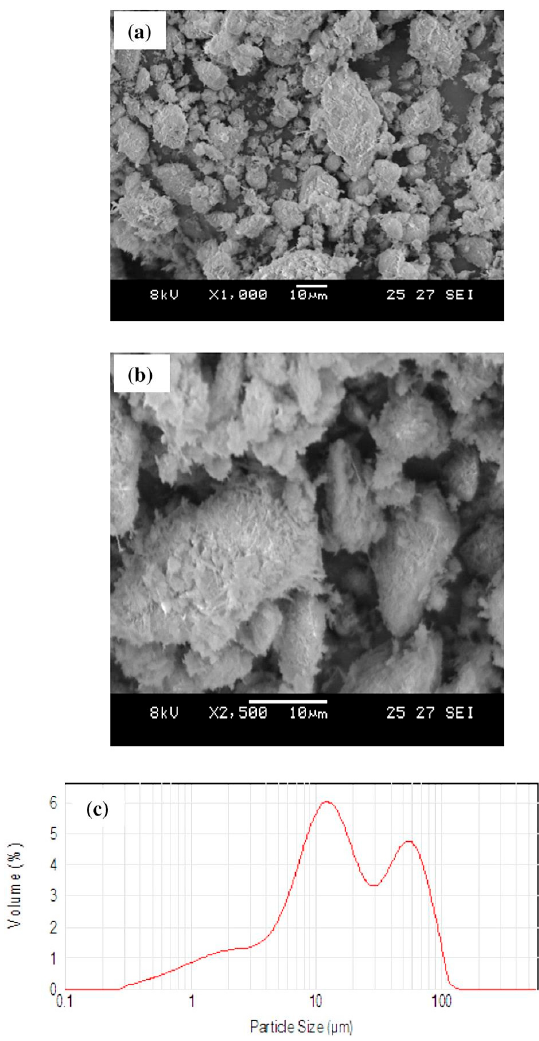
Figure 5. Raw halloysite, ( a , b ) SEM images, and ( c ) particle size distribution [50].